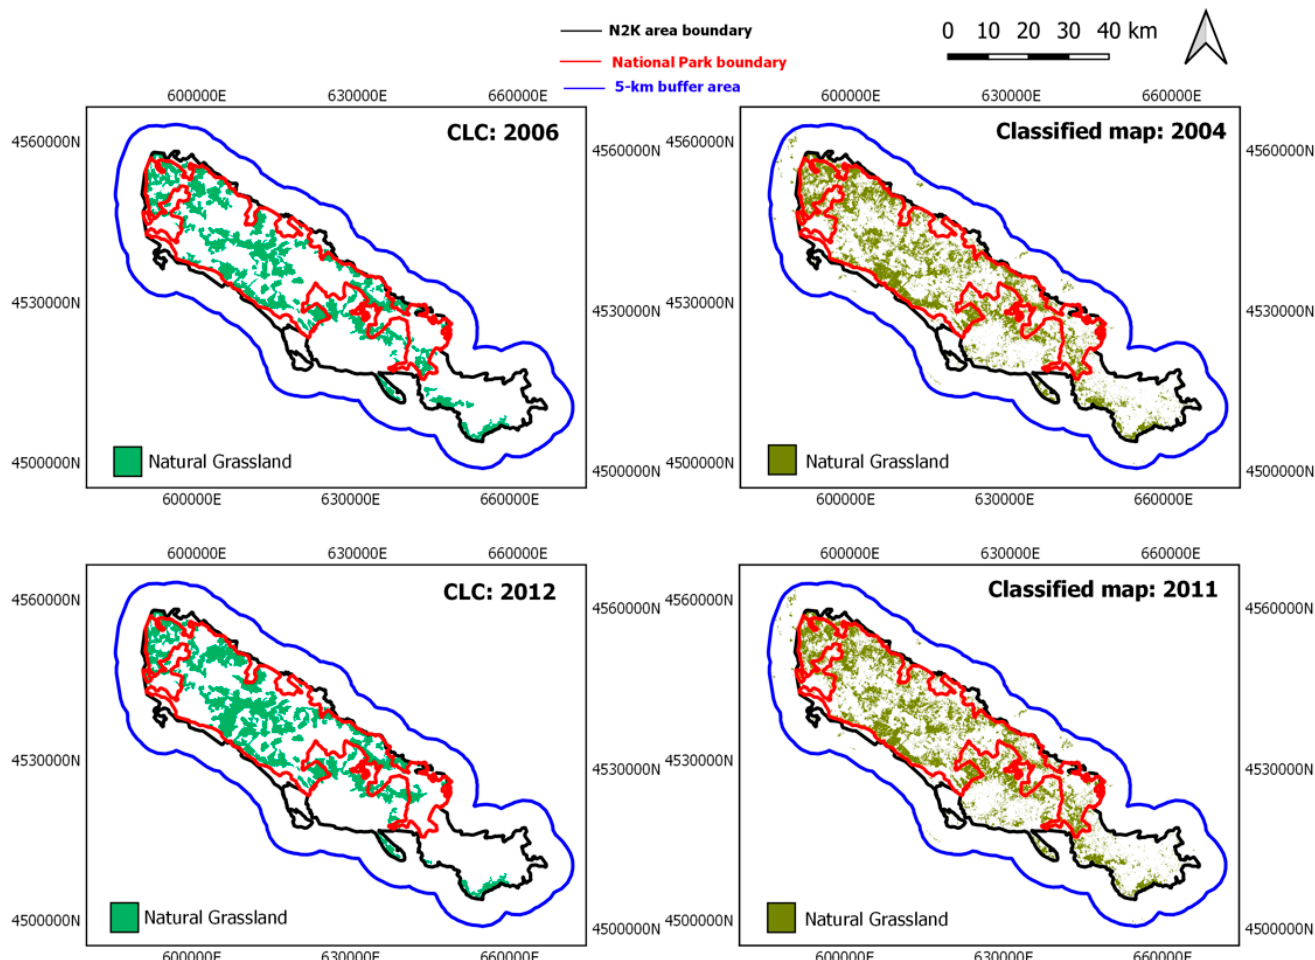
Figure 8. Grasslands classified mappings (30 m spatial resolution) for 2004 and 2011 on the right vs. CLC mappings (100 m spatial resolution) for 2006 and 2012 on the